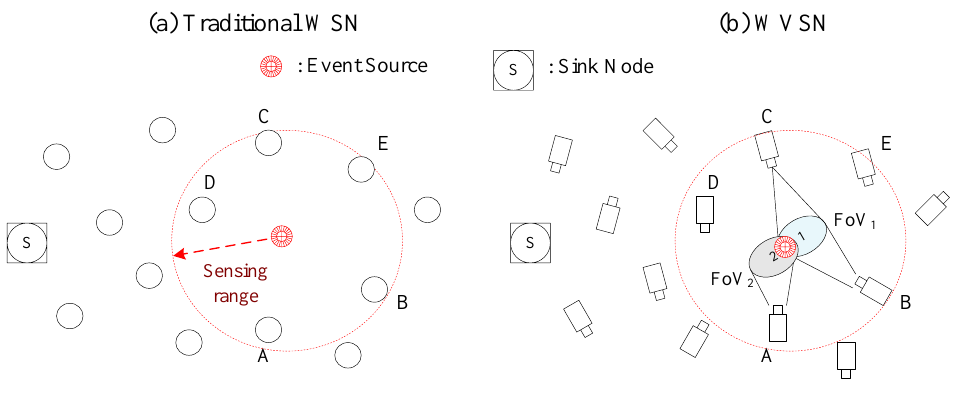
Figure 1. Wireless sensor networks vs . Wireless Visual Sensor Networks. Figure 1. Wireless Sensor Networks vs. Wireless Visual Sensor